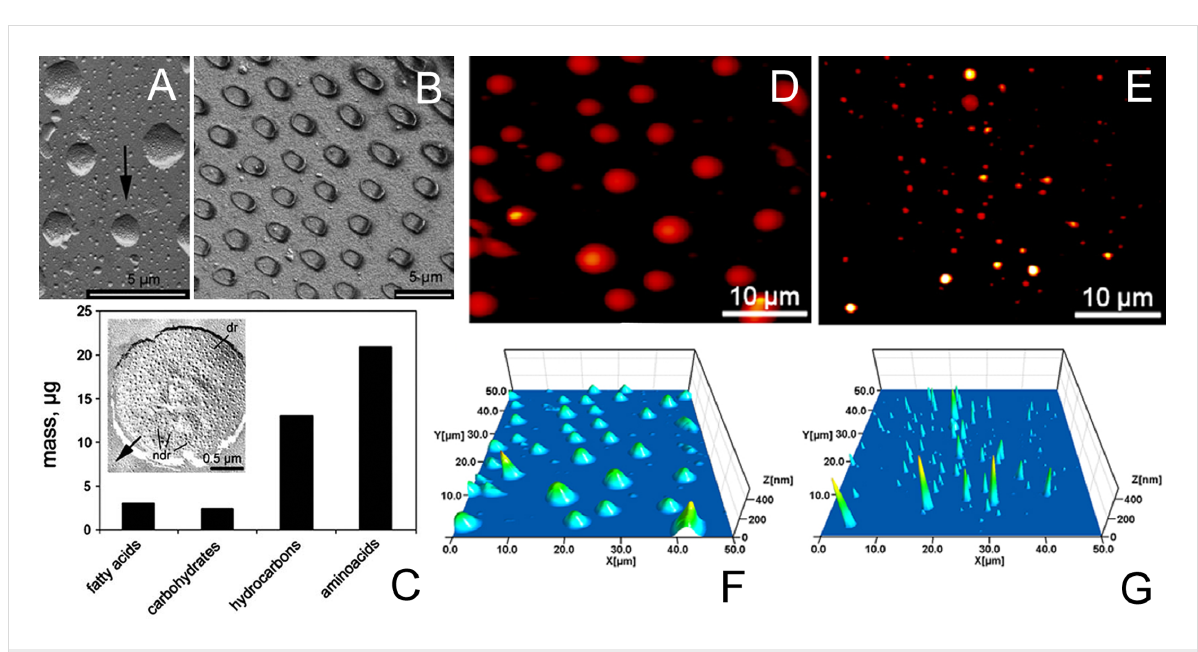
Figure 8: Fluid micro- and nanodrops in animal attachment pads. (A) Carbon–platinum replica of frozen and coated droplets of the fly Calliphora vicina in SEM (black arrow indicates the direction of coating). Please note the pattern of nanodrops on the surface of the major droplets (Figure 8A is from [3] and was adapted by permission from Springer Nature from “Attachment devices of insect cuticle” by S. N. Gorb, Copyright 2001 Springer Nature. This content is not subject to CC BY 4.0). (B) Menisci formed around single terminal contact elements of the setae of C. vicina . The fly leg was frozen in contact with smooth glass, carefully removed, and the fluid residues were viewed in cryo-SEM (Figure 8B is from [241] and was adapted by permission from Springer Nature from “Biological fibrillar adhesives: functional principles and biomimetic applications. In: Handbook of Adhesion Technology” by S. N. Gorb, Copyright 2011 Springer Nature. This content is not subject to CC BY 4.0.). (C) Chemical composition (absolute concen- tration of substance groups) of the pad secretion of the smooth euplantulae of Locusta migratoria (Figure 8C was adapted from [254], Insect Biochem. Mol. Biol., vol. 32, by W. G. Vötsch; R. Nicholson; Y.–D. Müller; S. Stierhof; S. N. Gorb; U. Schwarz, “Chemical composition of the attachment pad secretion of the locust Locusta migratoria”, pages 1605–1613, Copyright (2002), with permission from Elsevier. This content is not subject to CC BY